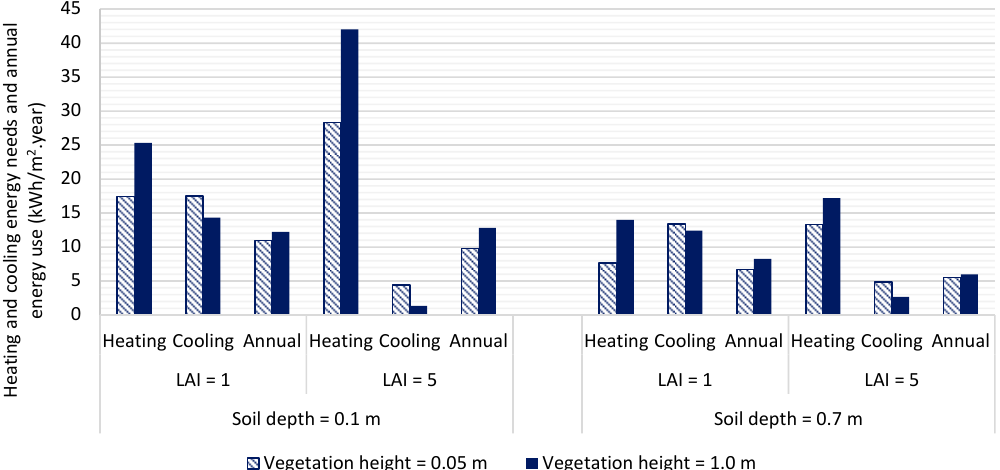
Figure 6. Heating and cooling energy needs and annual use for different LAIs, vegetation heights, and soil depths per sqm.